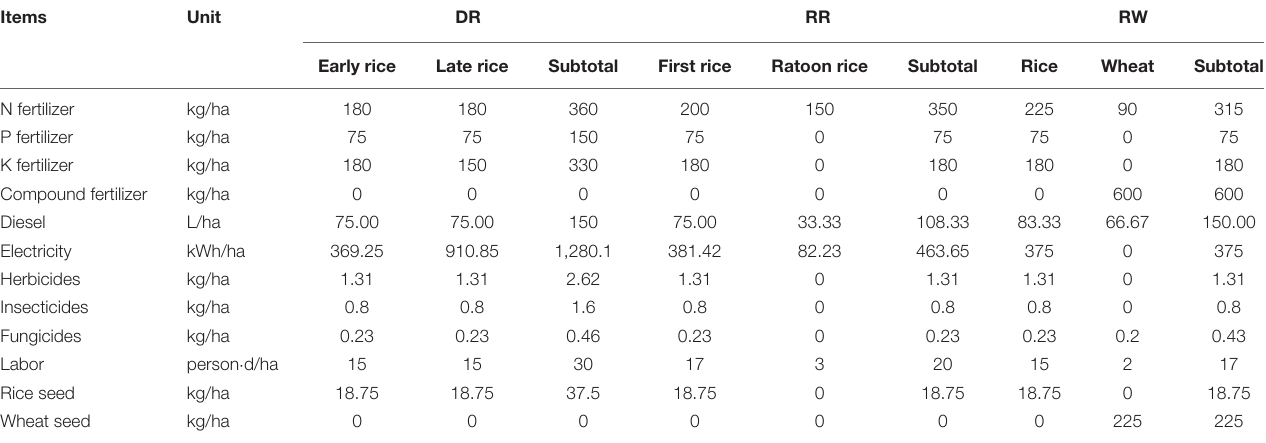
TABLE 1 | Life cycle inventory for the three rice cropping systems.